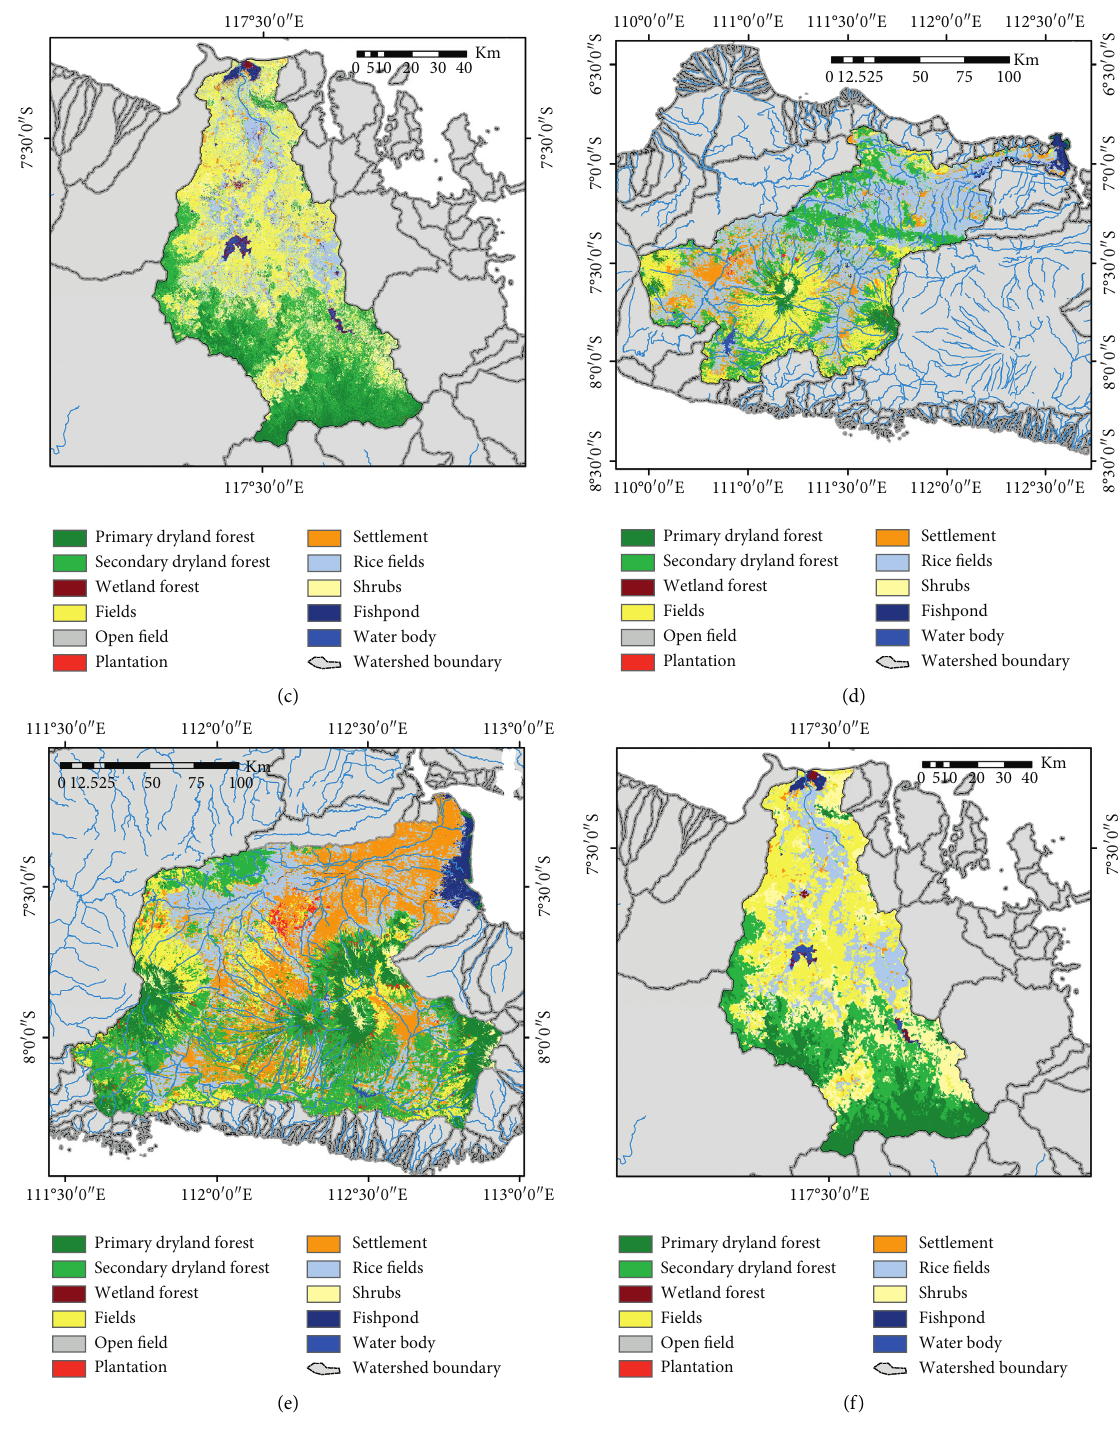
Figure 10: Results of the LULC classification based on the RF classifier: (a, d) Bengawan Solo watershed; (b, e) Brantas watershed; (c, f) Moyo watershed; process stage without the MaSegFil approach (a–c); process stage with the MaSegFil approach